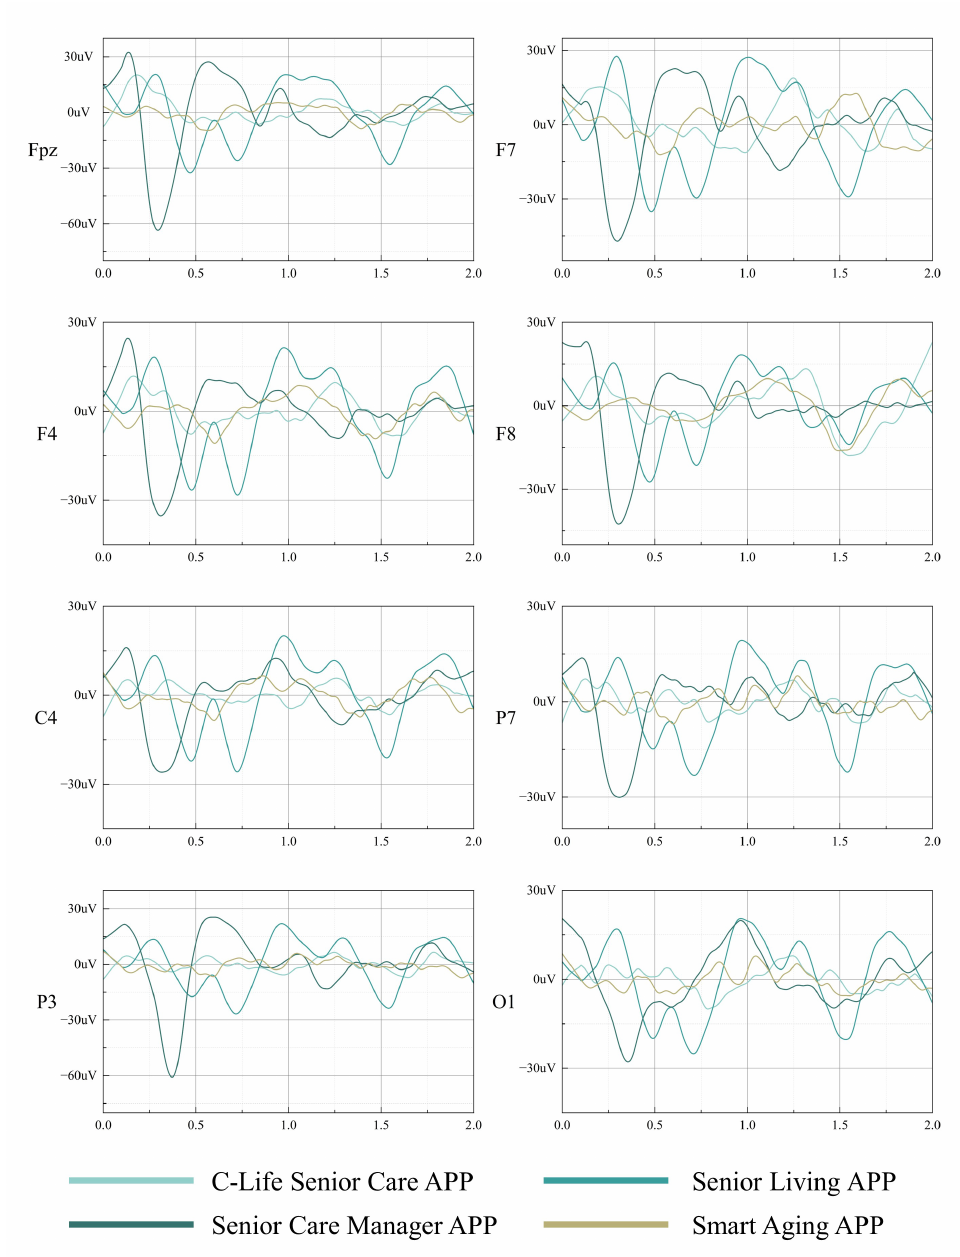
Figure 8. Electrode wave forms of different APP processes for each electrode